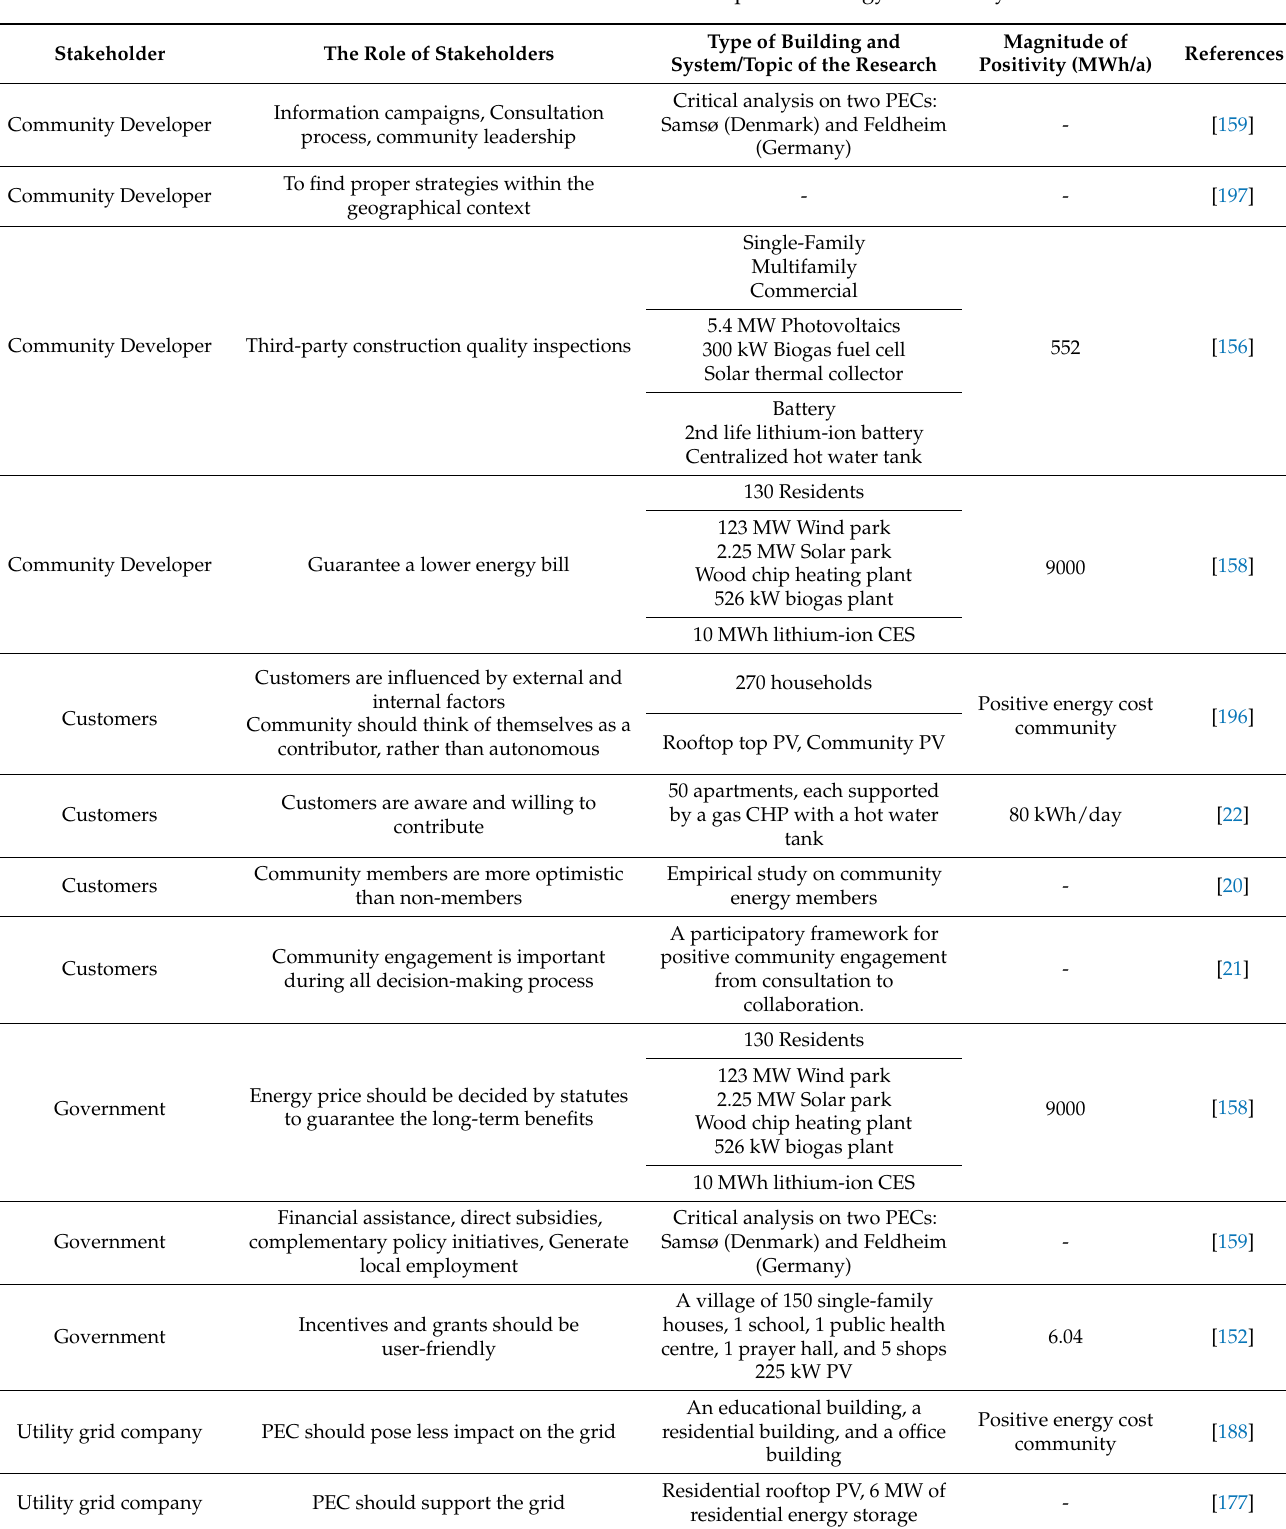
Table 5. The role of different stakeholders in a positive energy